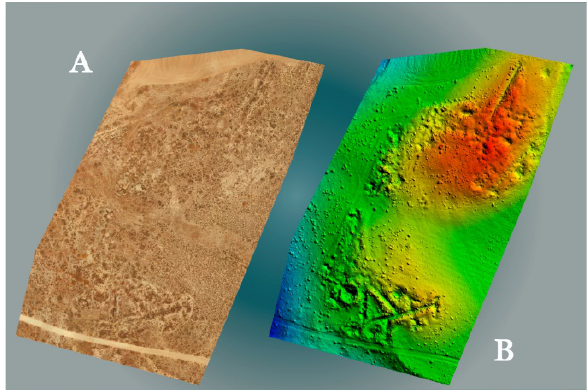
Figure 4. Remote sensing of Spanish Civil War structures with drone. A. High-resolution orthoimage; B. Visualization of trenches, shelters and artillery impacts using a Digital Elevation